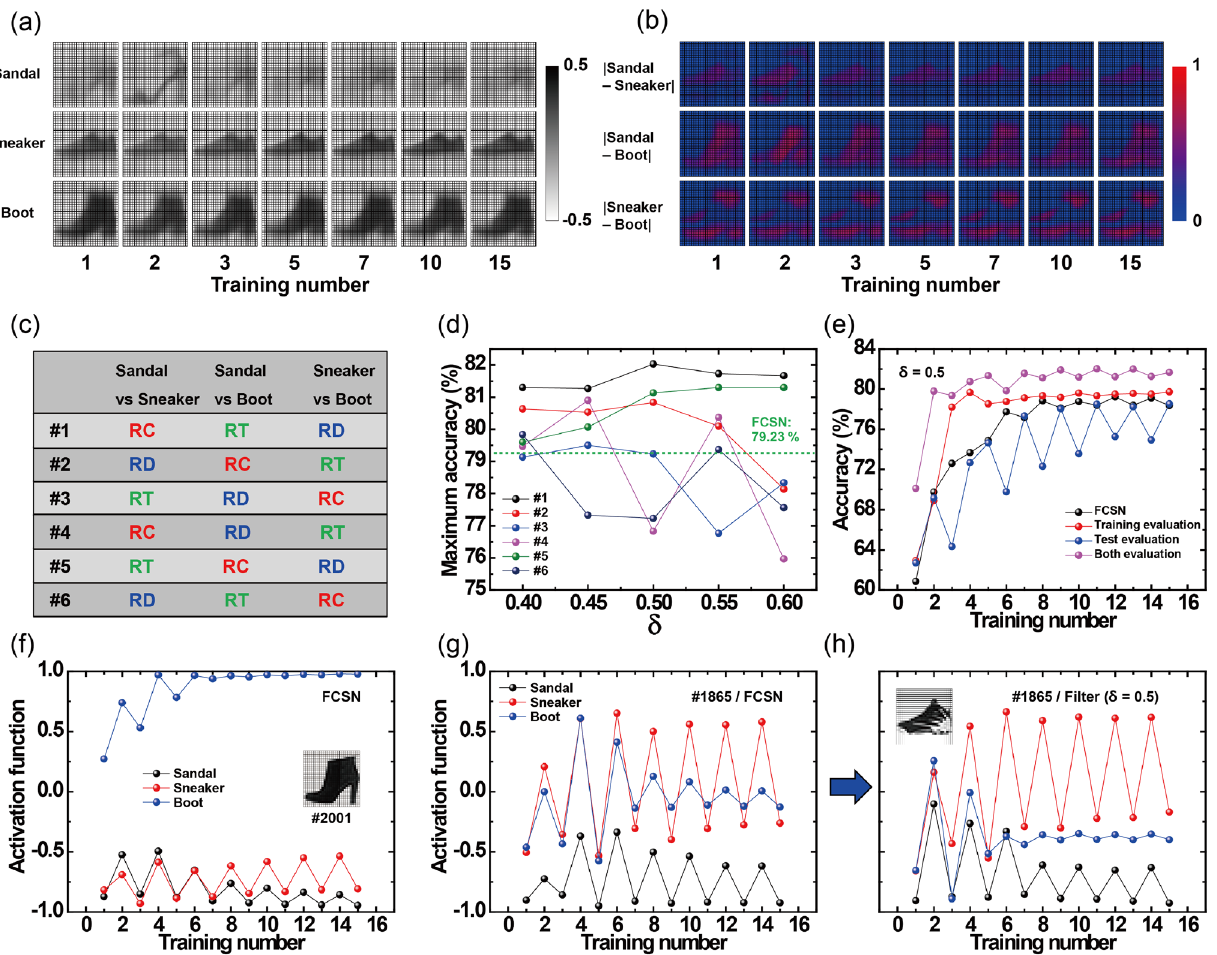
Figure 2. ( a ) Average magnitude of the classified training images for each output class at each training epoch in FCSN and ( b ) absolute difference between the two classes, where the red pixel indicates the more distinguishable region and the blue pixel indicates a similar region. ( c ) Arrangement of the 3-filter location along the competitive output classes. ( d ) The maximum inference accuracy in 15 training numbers depends on the filter arrangement in ( c ), where the #1 case (black line) showed the best improvement at a δ-value of 0.5 compared with the result in the FCSN without filter evaluation (green dash line). ( e ) Evolution of inference accuracy during 15 training numbers for the FCSN (black line) and with filter evaluation only in the training process (red line), only in the test process (blue line), and in both the training/test processes (magenta line). Evolution of activation function values during 15 training numbers for test image ( f ) #2001 and ( g ) #1865 in the FCSN. ( h ) Enhanced separation of activation function values for test image #1865 with filter evaluation at a δ-value of